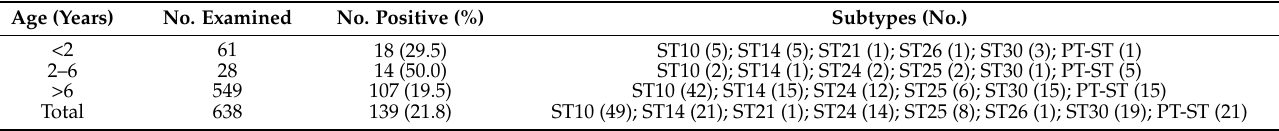
Table 2. Age distribution of Blastocystis sp. in Camelus bactrianus in